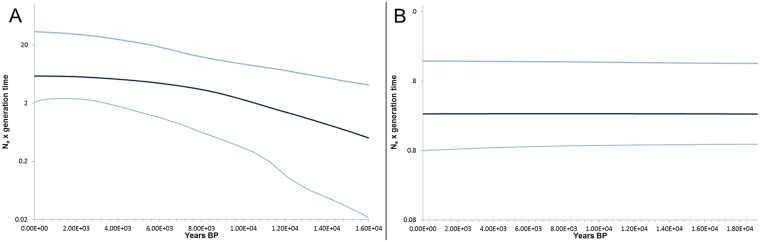
Bayesian skyline plot of Lucanus cervus created with the COI dataset.The y-axis represents the product of effective population size (Ne) and generation time (with units in millions of years) on a logarithmic scale. The black line gives the median of effective population size through time and the blue lines represent the 95% highest posterior densities over the median estimates along the coalescent history. The x-axis gives years before present.